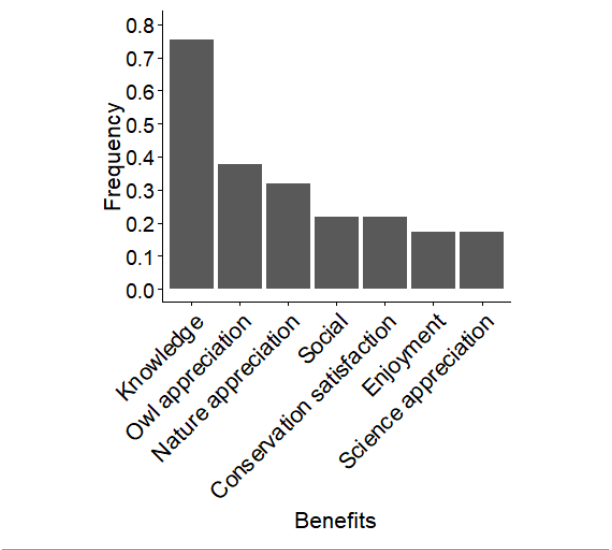
Fig. 1 . Common benefit categories identified by participants of the Manitoba Nocturnal Owl Survey in an open-ended question as part of questionnaire on participation behavior and scientific attitude distributed during November 2015–January 2016 (n = 69). Some respondents identified multiple